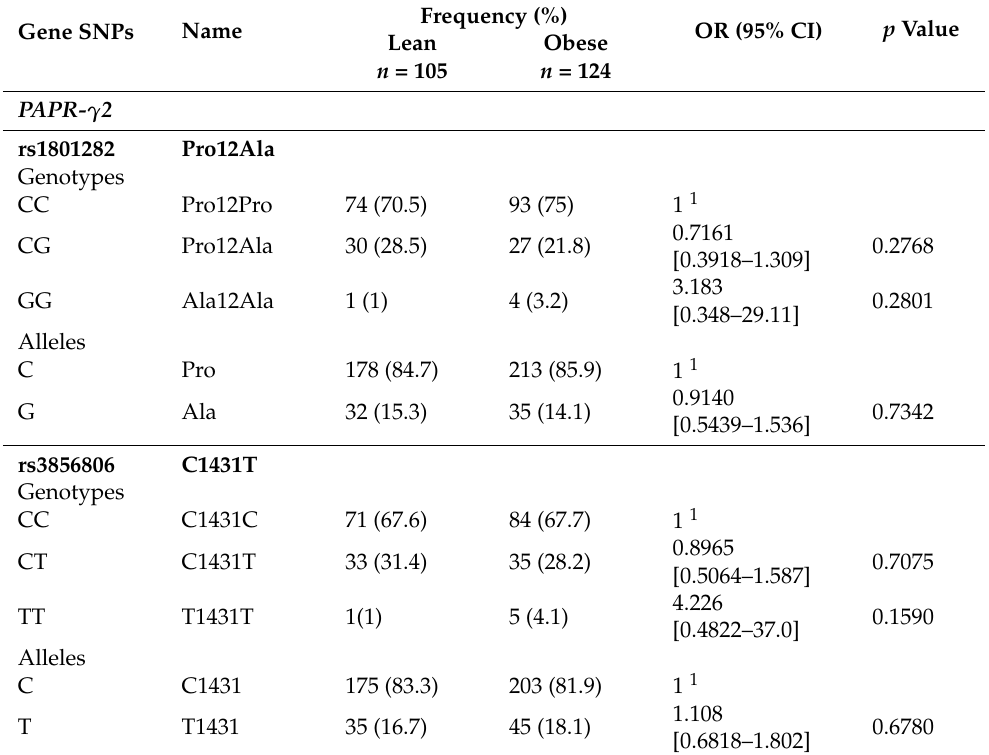
Table 2. Frequency of analyzed PAPR- γ 2 , β 3-AR , and FAM13A polymorphisms between lean and obese